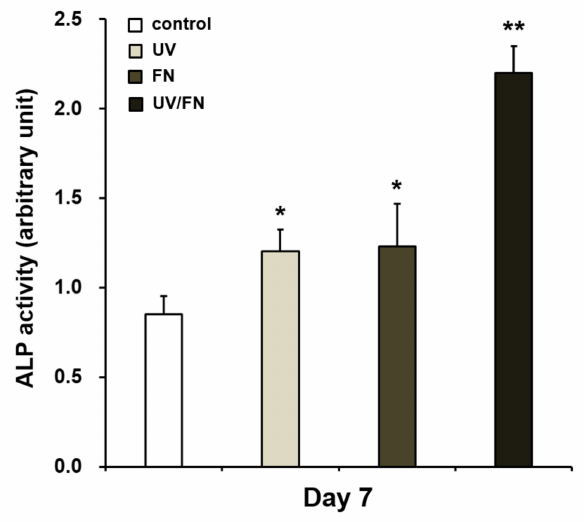
Figure 5. UV treatment enhanced the activity of alkaline phosphatase (ALP), a marker of early- to middle-stage osteoblast di ff erentiation, on control, UV-treated (UV), fibronectin-adsorbed (FN), and UV-treated and fibronectin-adsorbed (UV / FN) titanium surfaces. A 1-h adsorption protocol was used in this experiment. ALP activity on day 7 was quantified by colorimetry and standardized relative to cell number. Each value represents the mean ± standard deviation of triplicate experiments ( n = 3). * p < 0.05 and ** p < 0.01 represent significant di ff erences relative to the control